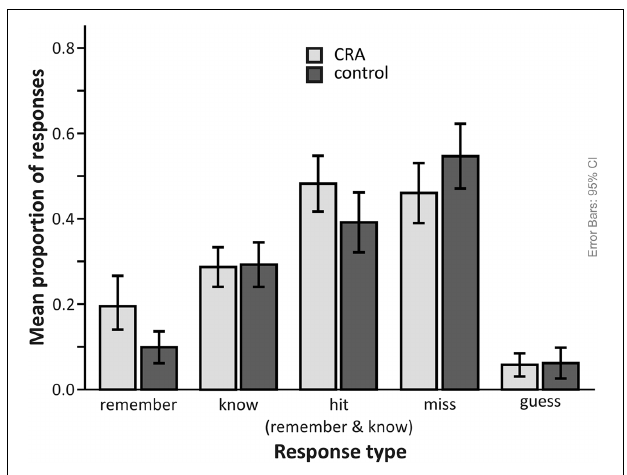
FIGURE 3 | Recognition memory performance (proportion of responses) for CRA (induced insight) and control items. The data are split for response category (remember, know, guess, miss). To provide an overview, all responses considered hits, i.e., correctly recognizing items as old, are represented in the “hit (remember and know responses)”